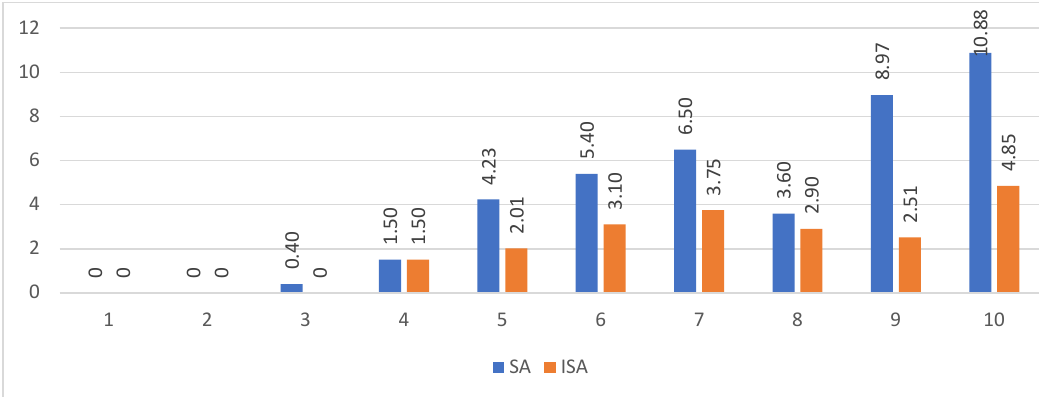
Fig. 9. The quality of solutions in small-sized